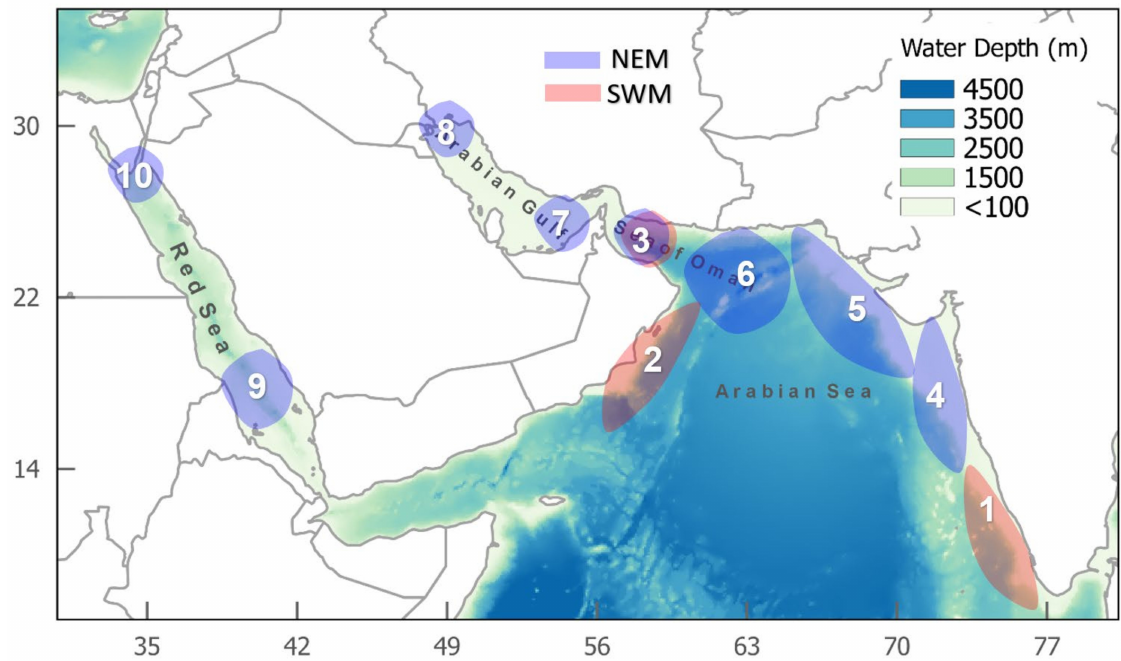
Figure 1. Bathymetric map of the northern Indian Ocean including the Arabian Sea, Sea of Oman, Arabian Gulf, and Red Sea. The Arabian Sea is the deepest with water depth >4 km, indicated by the dark blue, and the Arabian Gulf is the shallowest with water depth <100 m, indicated by the light green color. The circles show the hotspots of the algal blooms in the NIO. The red circle represents the algal blooms that commonly occur during the SWM, and the blue circle represents the algal blooms that happen during the NEM. The numbered circles indicate the regions of ten algal bloom hotspots (from 1 to